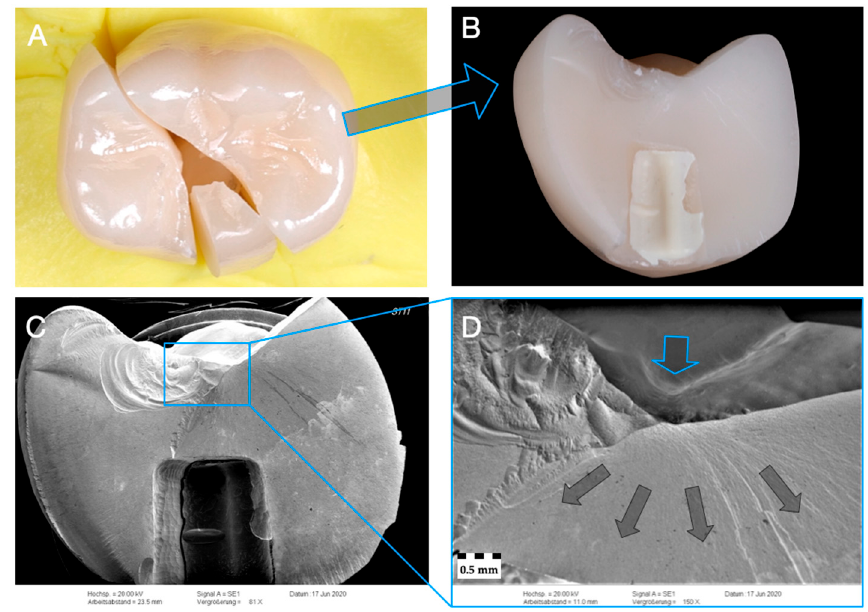
Figure 6. Representative specimen of Group Z-ST after single-load-to-fracture assessment. Light microscopy shows ( A ) occlusal view of bulk fractured specimen and ( B ) side view of fractured part marked with blue arrow. SEM pictures: ( C ) overview of fractured part at low magnification of ( B ). Detailed view at high magnification ( D ): blue arrow indicates fracture initiation point, while dark arrows represent the direction of crack